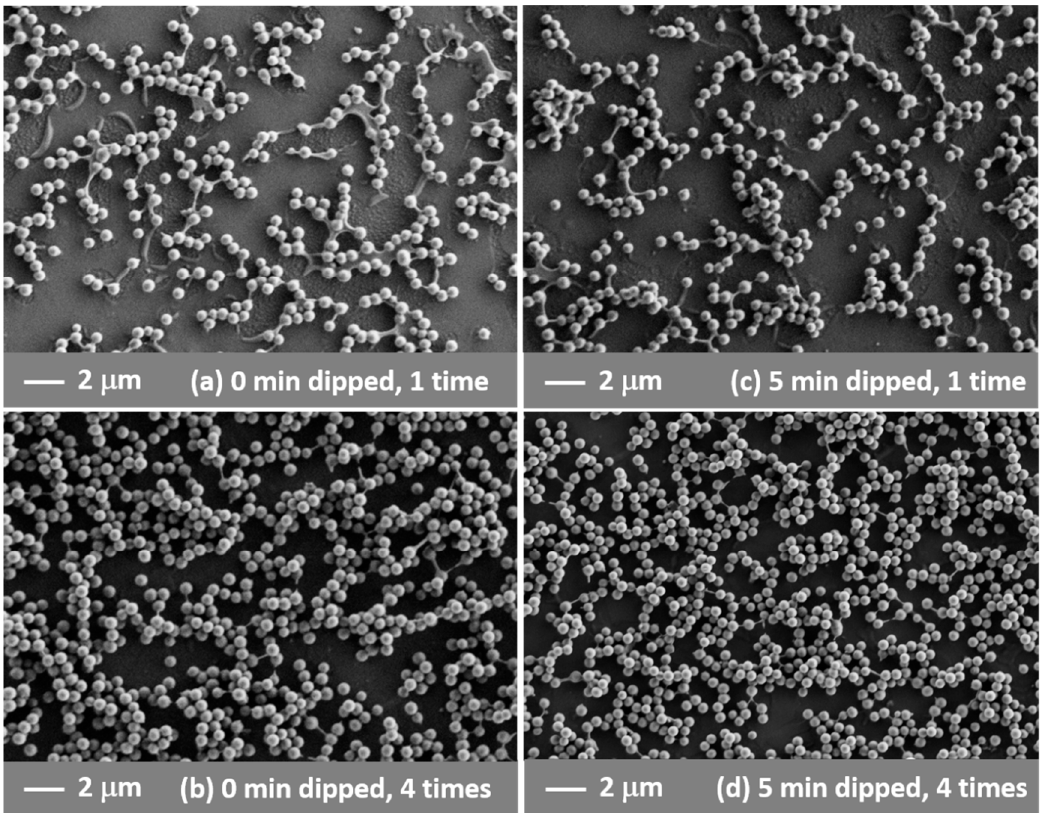
Figure 4. SEM images of hydrophobic silica coatings aged for 5 days, varying the dipping conditions: ( a ) dipped for 0 min once, ( b ) dipped for 5 min once, ( c ) dipped for 0 min four times and ( d ) dipped for 5 min four times.